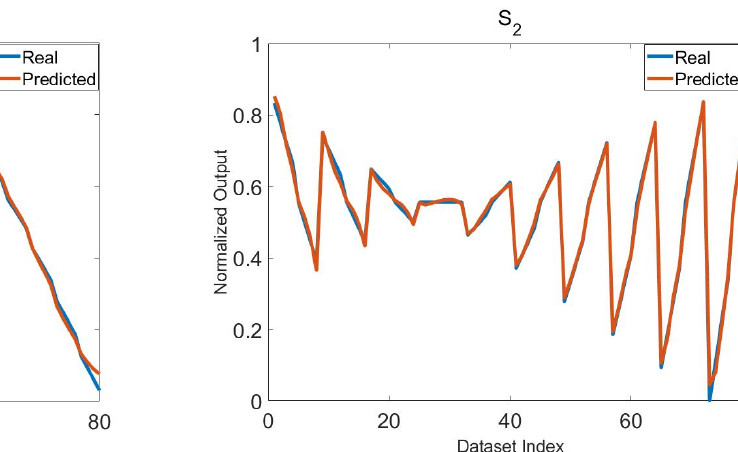
Figure 6. Comparison of the convergences of the ABC, aABC, ABCES and HABCES algorithms for nonlinear static system identification.